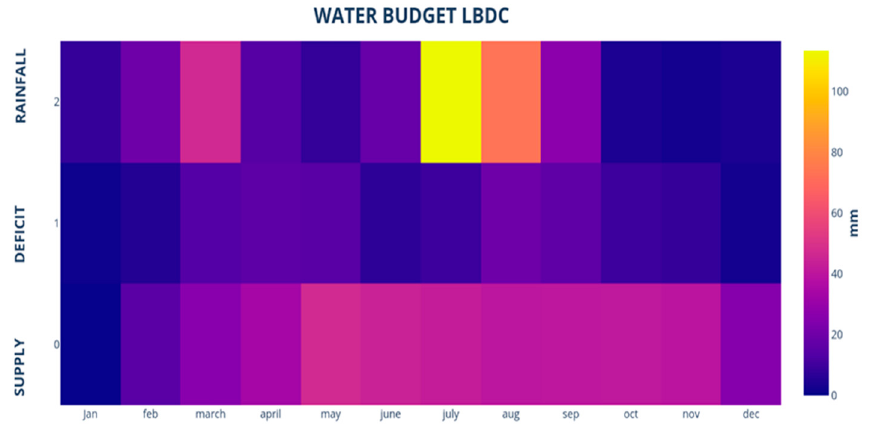
Figure 16. Water balance heat map for year 2015 (developed in R-Studio).